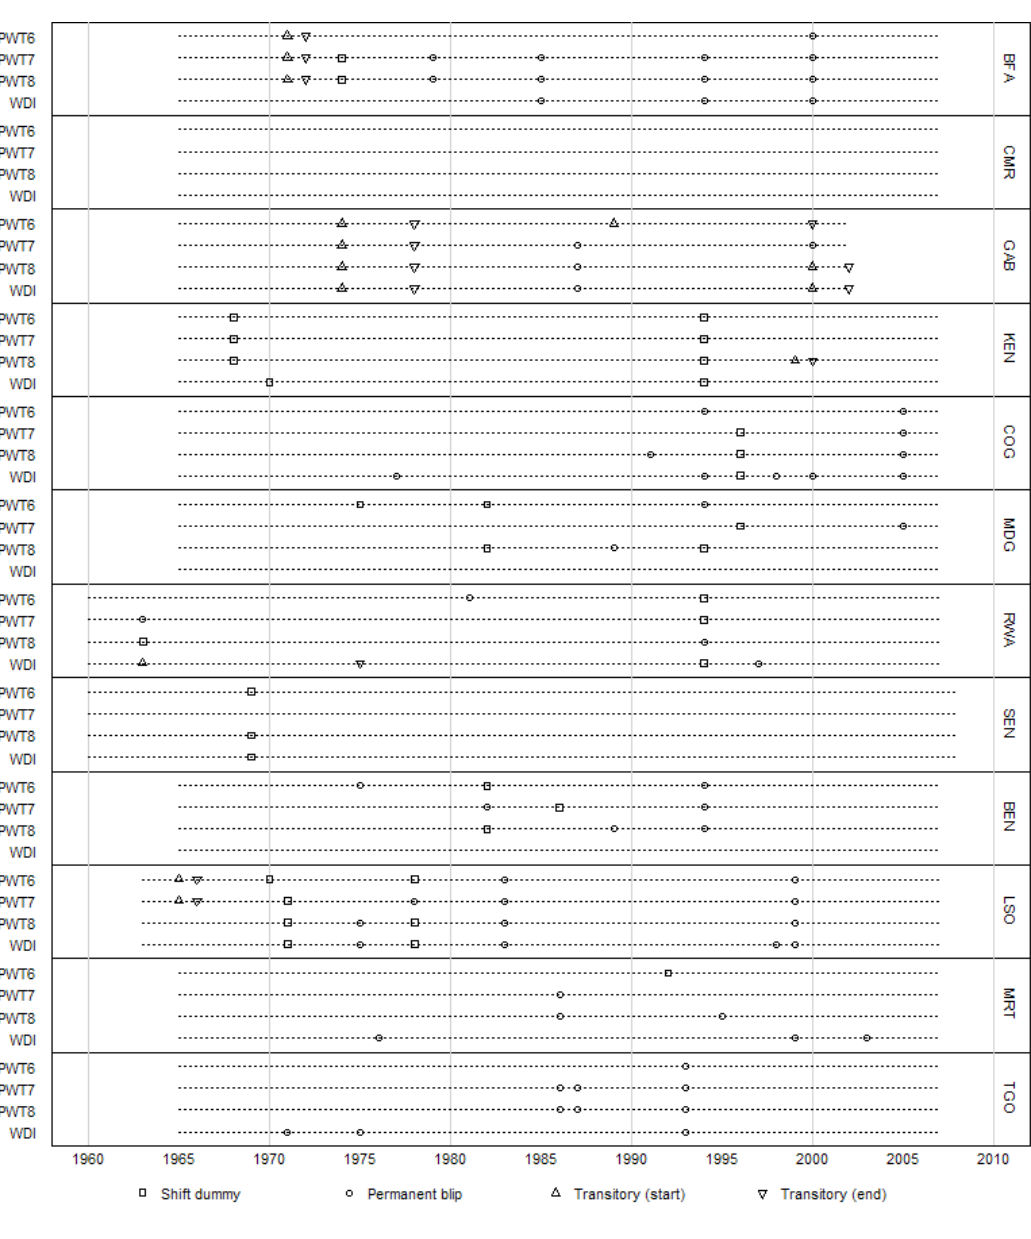
Figure 4: Timeline of dummy